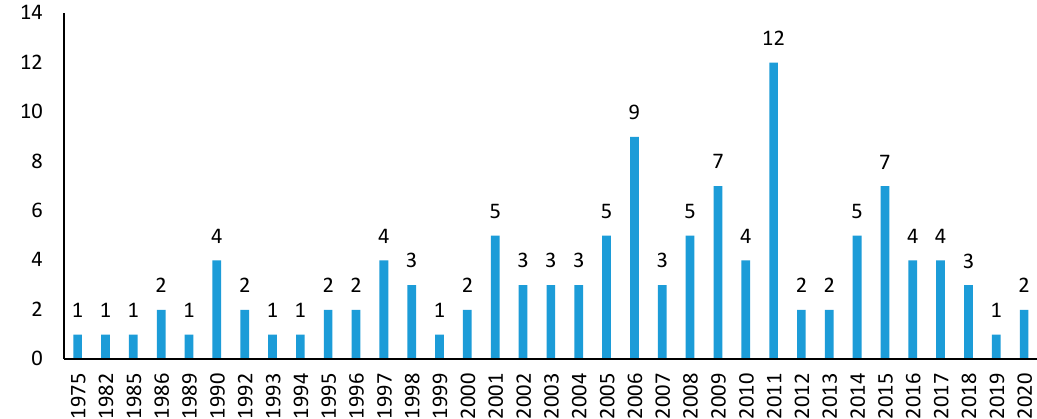
Figure 1. Studies analysed according to publication year ( n = 118). Source: own elaboration.